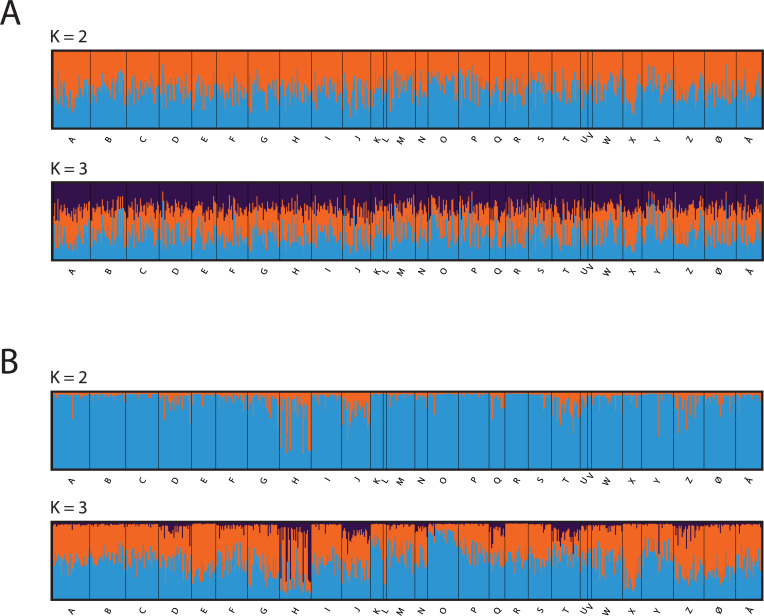
Population genetic structure for the apple fruit moth (A. conjugella) on the Scandinavian Peninsula in 2016 (n = 669) using 10 STR loci.Bayesian assignment was performed using the program STRUCTURE with bar plots for K = 2 to K = 3, without (A) and with (B) LOCPRIOR.